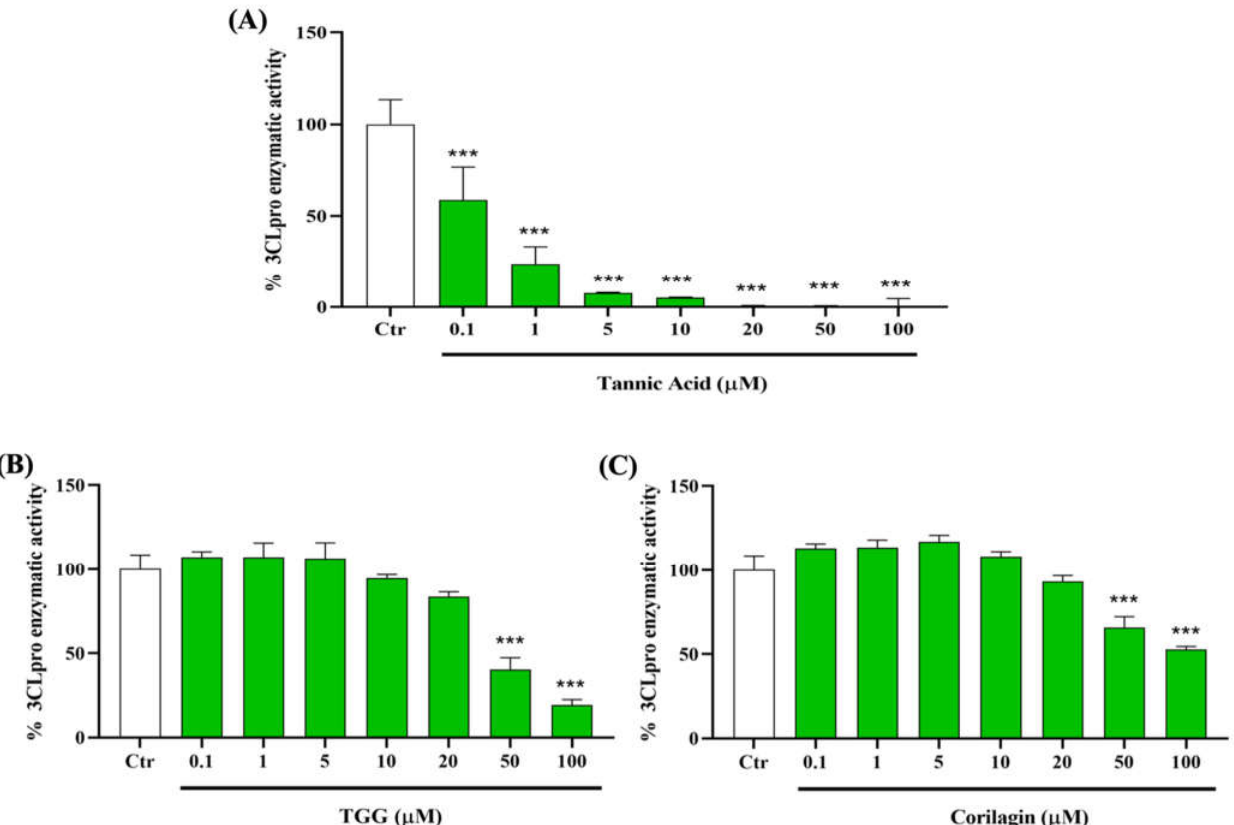
Figure 5. Inhibitory effects of TA, TGG, and corilagin on SARS-CoV-2 3-chymotrypsin like protease (3CLpro) activity. Different concentrations (0.1 to 100 μM) of ( A ) TA, ( B ) TGG, and ( C ) corilagin are tested on the activity of 3CLpro. The fluorescence units in control conditions are considered as 100%. Blank values are subtracted from all the readings before the conversion into percentage of activity. Results are expressed as mean ± SD (n = 3). Statistical analysis is performed using one-way ANOVA followed by the Tukey post hoc test with *** p < 0.001 compared to positive control wells.